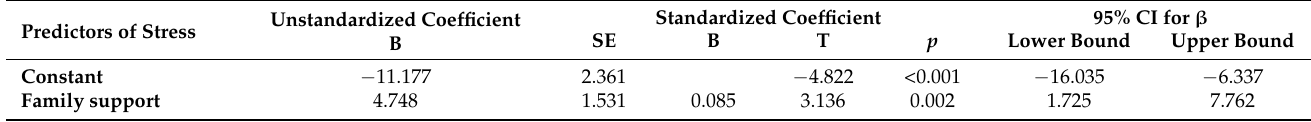
Table 6. Linear regression model of sociodemographic characteristics that predict